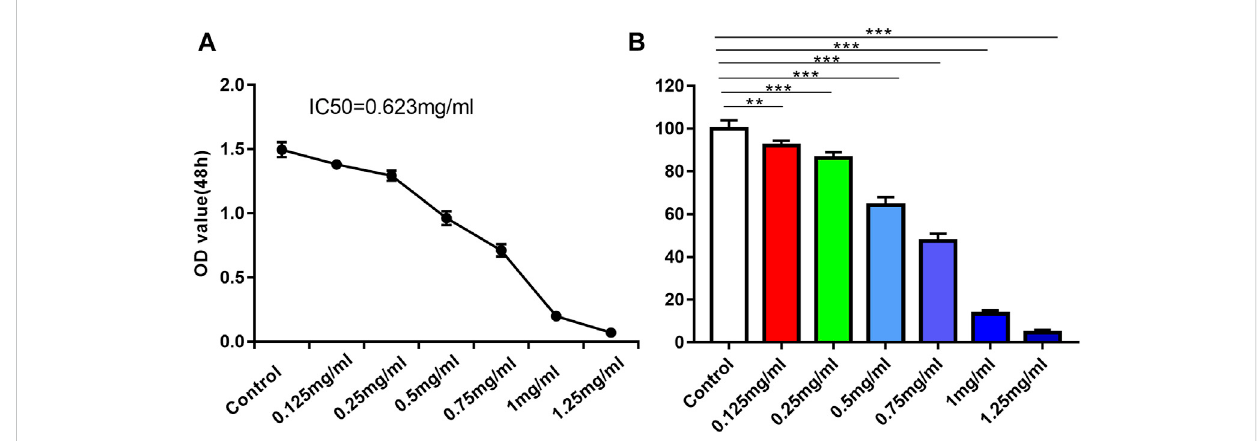
FIGURE 3 (A) IC50linediagramofDTinhibitionofAMSECscells. (B) DTsigni fi cantlysuppressedAMESCsproliferation.Datawereexpressedasmeans±SD,** p < 0.01, *** p < 0.001 versus the Control group.